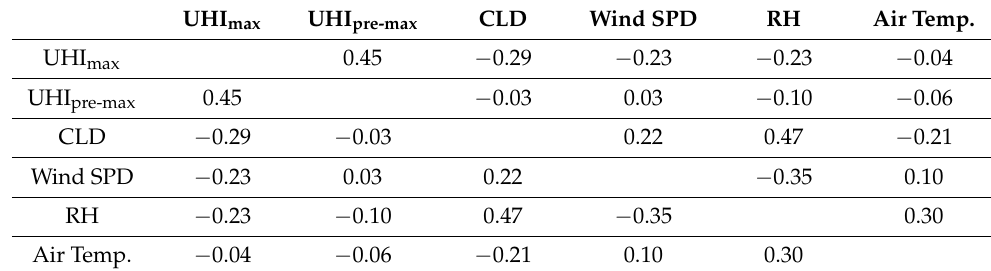
Table 4. Partial correlation analysis of UHI parameters and meteorological elements